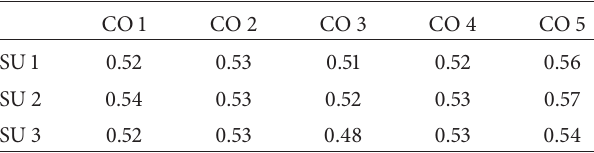
Table 7: Correlation matrix for the daily energy output at the locations of Coesfeld and Suedlohn for the analyzed